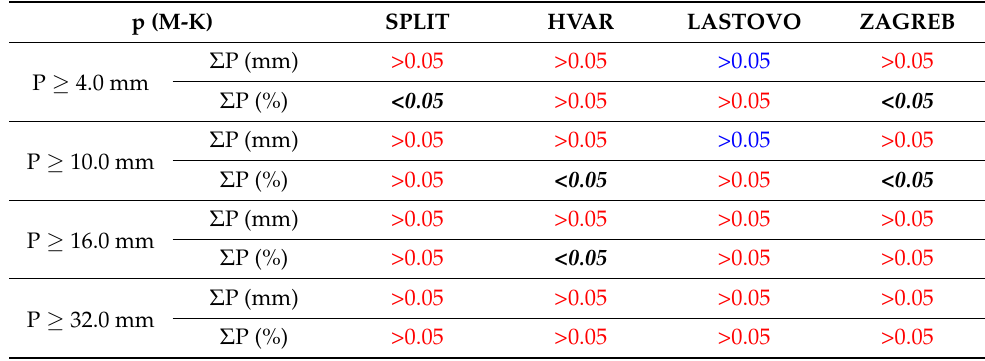
Table 6. Matrix with the results of the probability of the Mann–Kendall test, p (M-K).